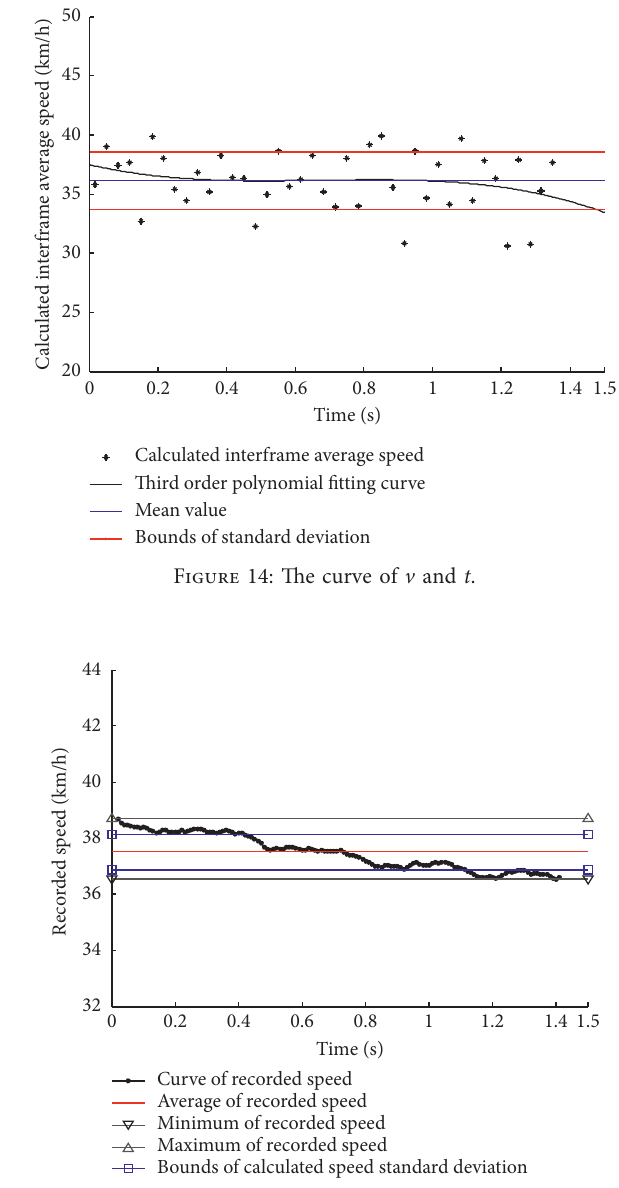
Figure 15: Compared analysis between v